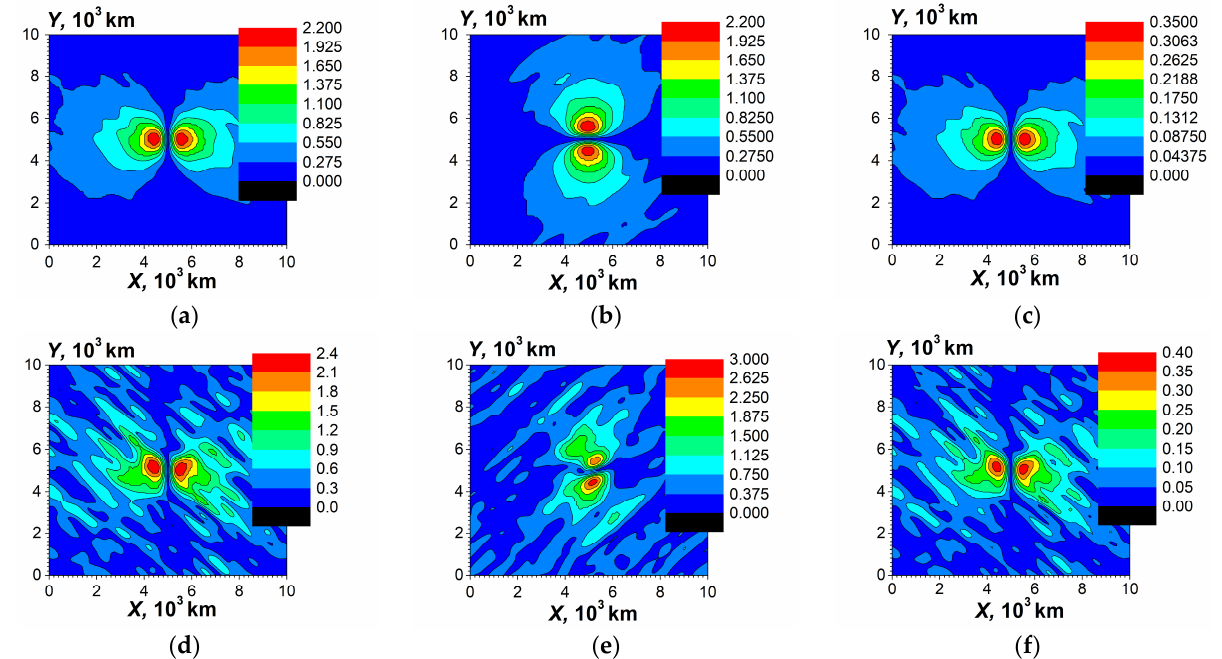
Figure 9. Distributions of the electric field components (in mV/m) in the ionosphere F -layer at the height z = 200 km. The dynamic simulations, the case of closed geomagnetic field lines. The total vertical distance of the simulation is L z = 2000 km. The geomagnetic field inclination is θ i = 10°. Parts ( a – c ) are for ω = 0.05 s − 1 , ( d – f ) are for ω = 0.025 s − 1 . Parts ( a , d ) are |E x (x,y)| ,( b , e ) are |E y (x,y)| , ( c , f ) are |E z (x,y)| .